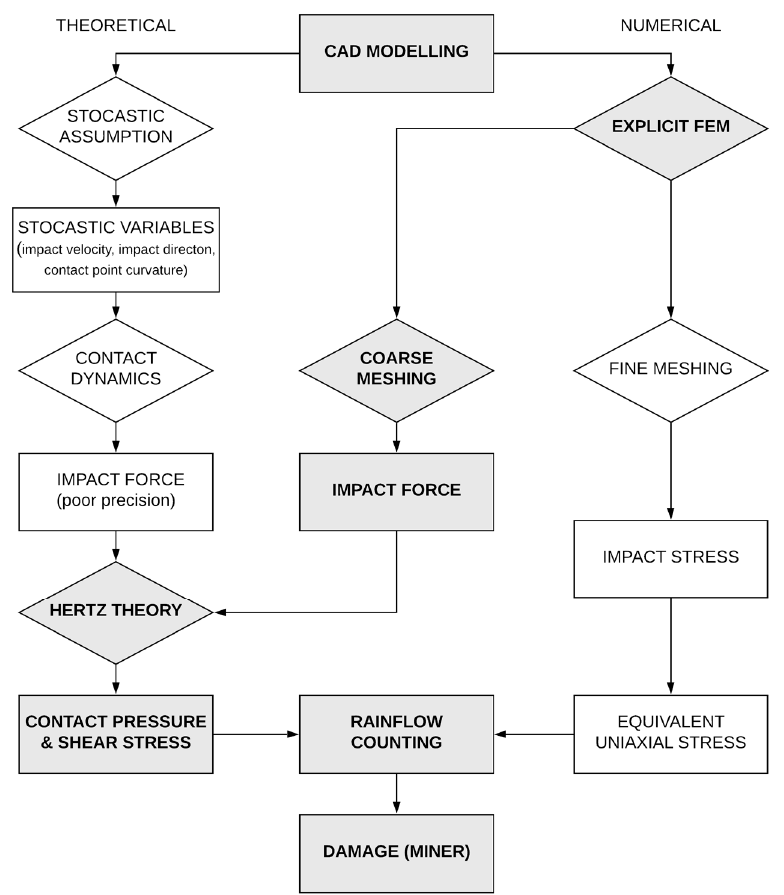
Figure 10. A flow chart summarizing the theoretical and numerical methods (white boxes) and the proposed approach (grey boxes).